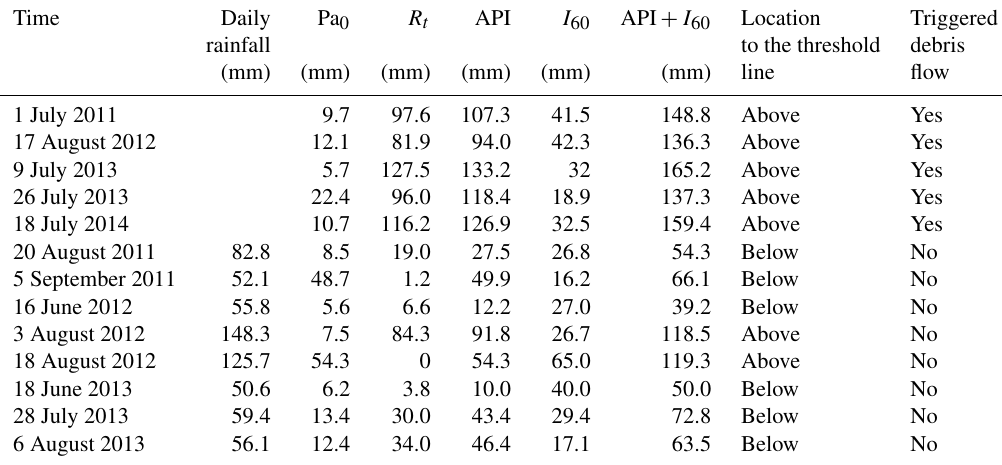
Table 7. The data of typical rainfall in the Guojuanyan gully after the earthquake. Time Daily Pa 0 R t API I 60 API + I 60 Location Triggered rainfall to the threshold